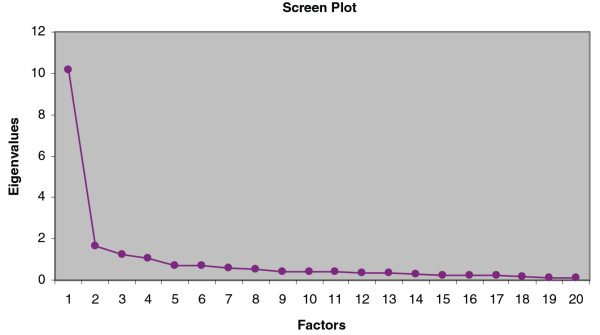
Screen plot analysis of factors in the PSO-LIFE questionnaire.